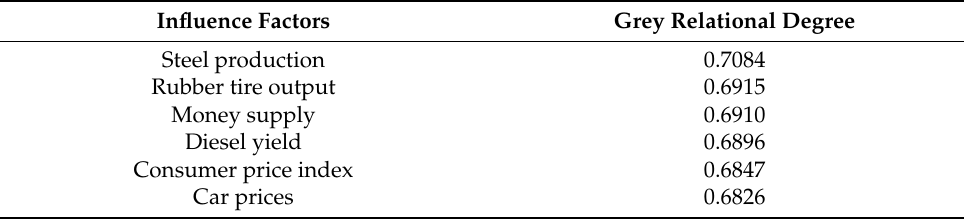
Table 2. Grey correlation between sales and influence factors of